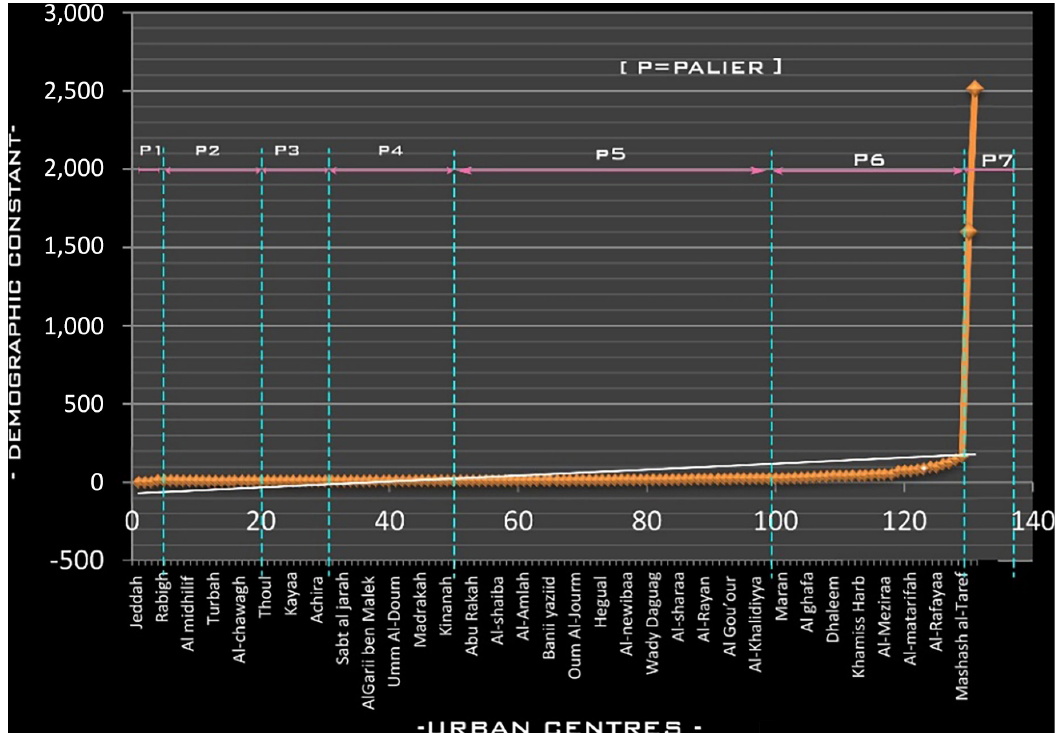
Fig. 5. The curve of demographic constants of urban centres of the Makkah Province.